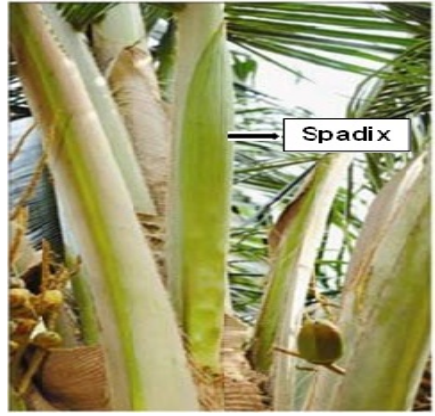
Figure 1. The unblossomed spadix of a mature coconut palm.